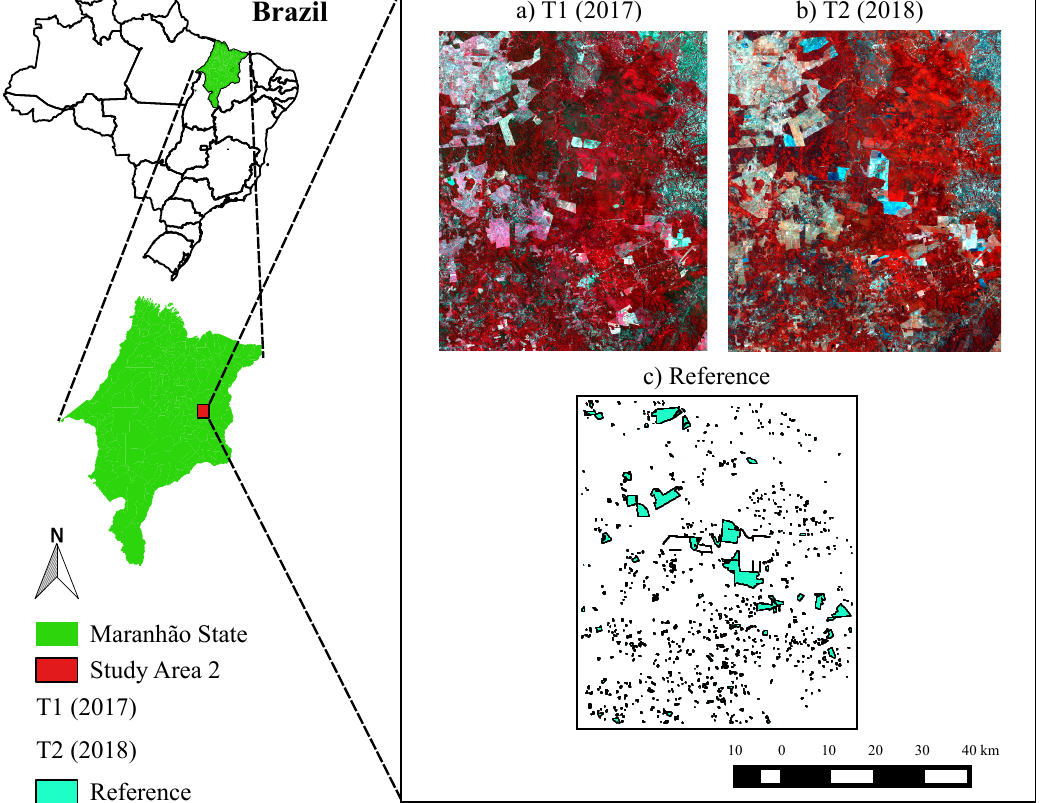
Figure 6. Region of the Brazilian Cerrado biome, located in Maranhão State, Brazil. NIRGB composition of the study area at two different dates T1 and T2 ( a , b ); ( c ) Reference of the deforestation process from 2017 to